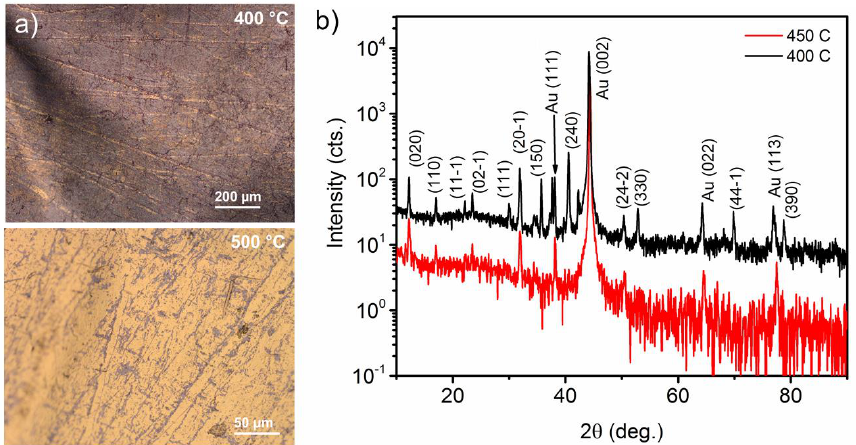
Figure 1. Structural characterization of Au 2 P 3 on Au films ( a ) optical images of films grown at 400 °C and 500 °C, and ( b ) X-ray diffraction (XRD) spectra from films grown at 400 °C and 450 °C. All of the peaks have been all indexed to Au 2 P 3 (JCPDS# 98-000-8058) or Au (JCPDS# 98-004-4362). Unlabeled peaks can be assigned to Au 2 P 3 .